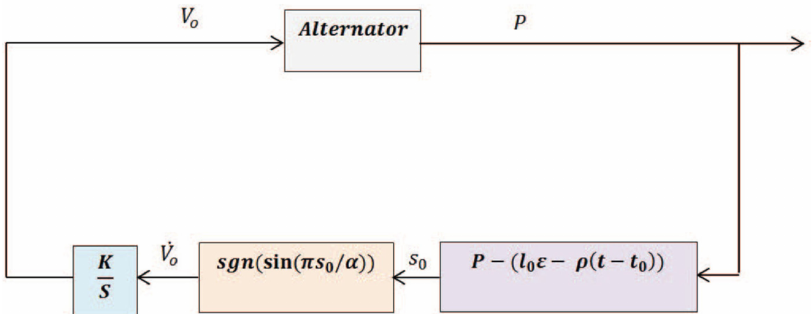
Figure 26. Proposed multi-surface sliding mode ESC block diagram “Adapted with permission from Ref.